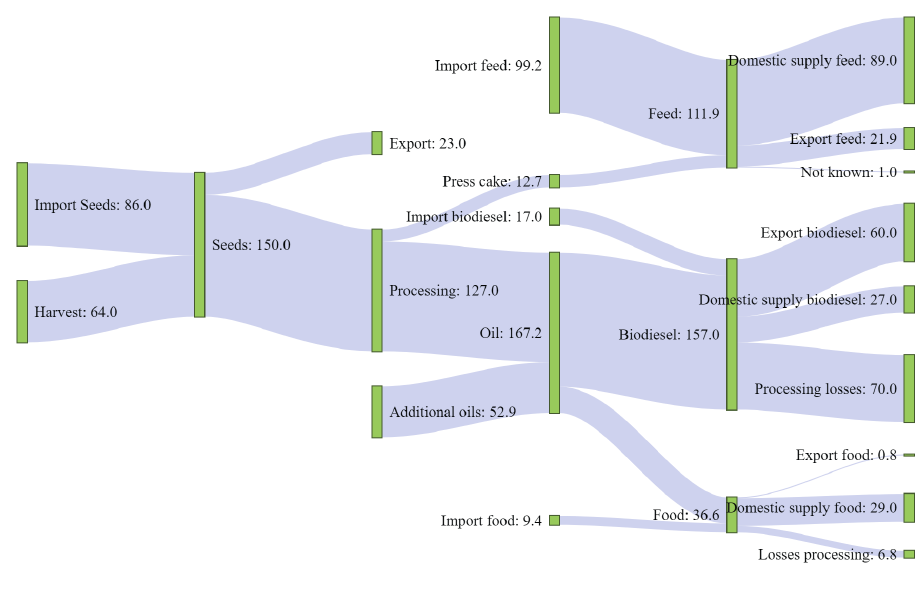
Fig. 4. Sankey diagram for bioresource flows of base scenario in 2015 for vegetable oils, thousand